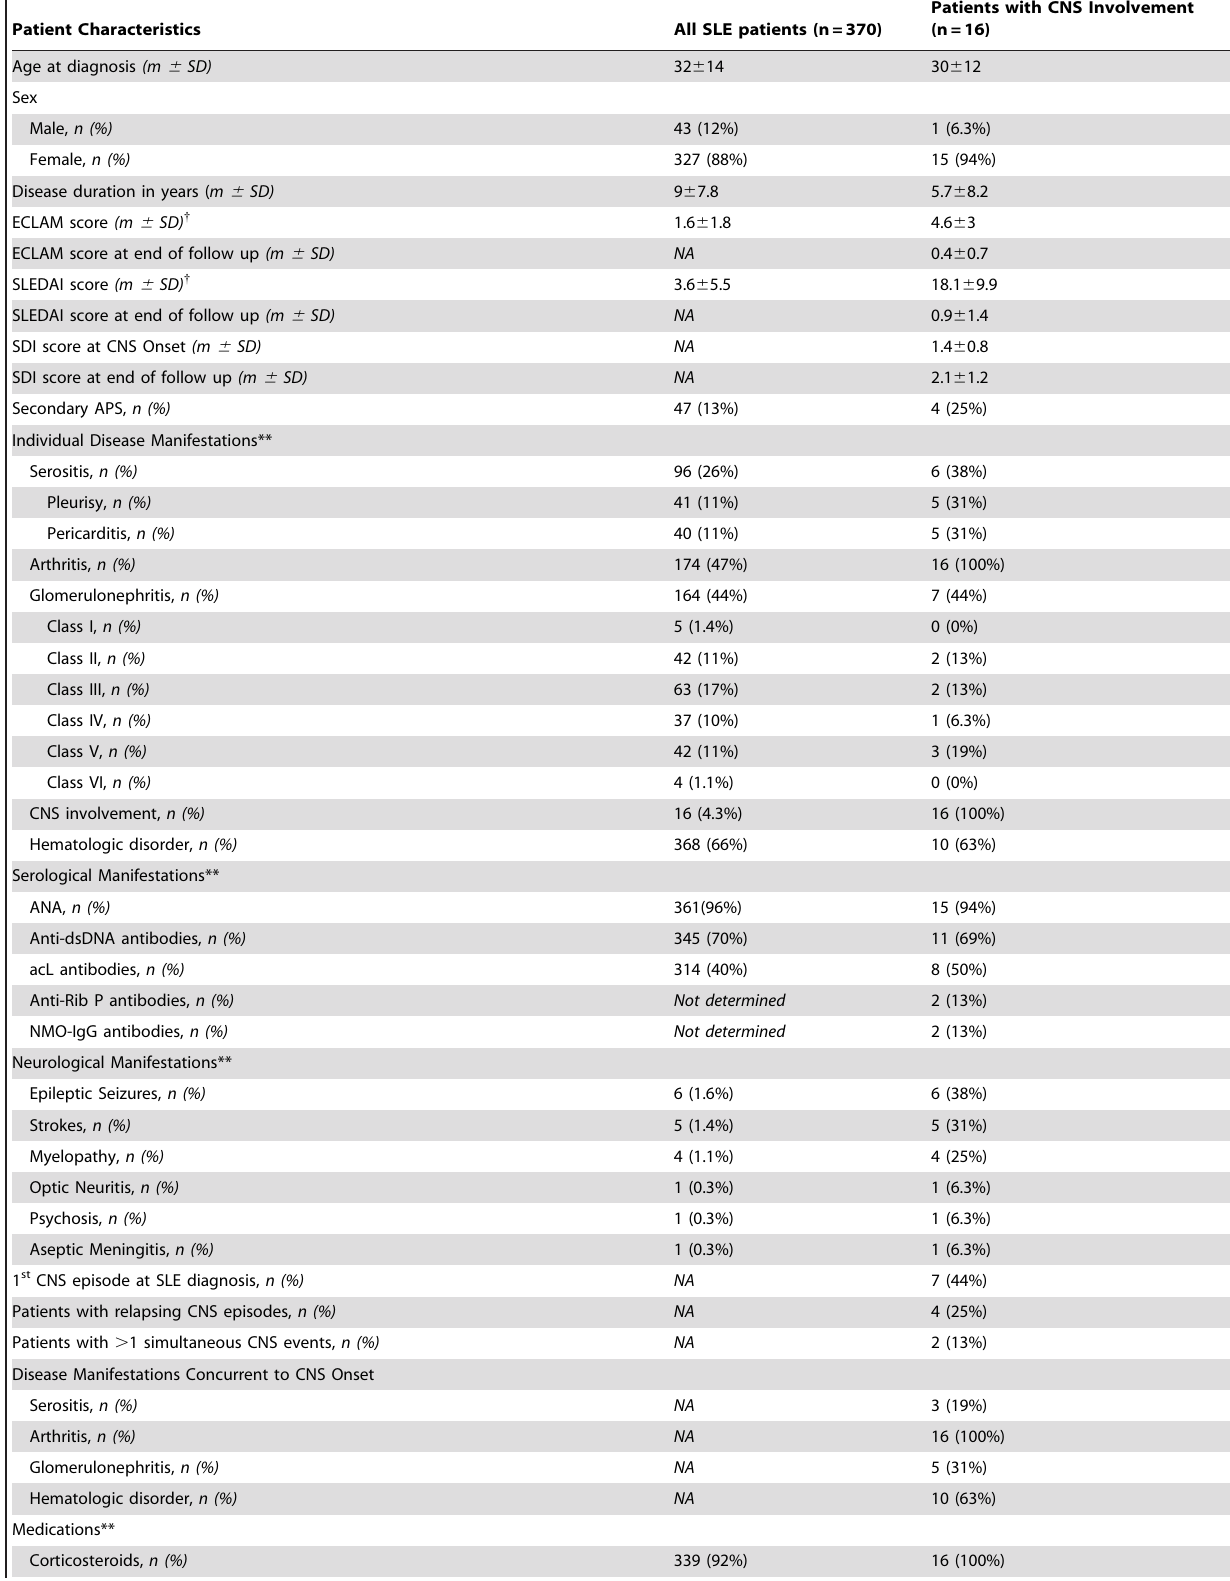
Table 1. Demographic and clinical characteristics of the SLE